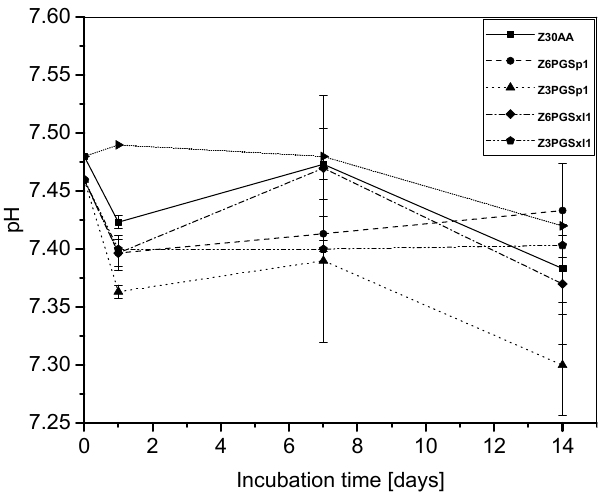
Figure 7. pH change of the different degradation media of neat zein and zein-PGS fiber mats at specific time points.